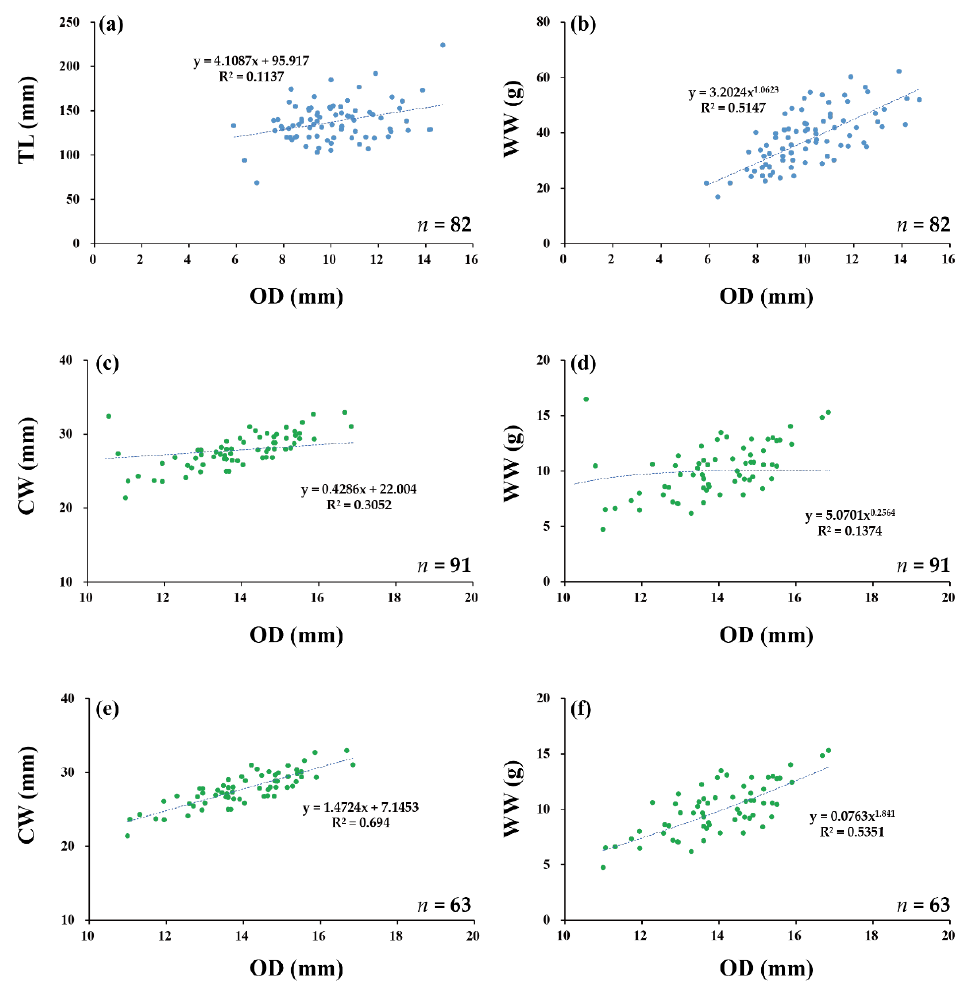
Figure 4. The relationship between ( a ) OD and TL for U. unicinctus , ( b ) OD and WW for U. unicinctus , ( c ) OD and CW for U. major , ( d ) OD and WW for U. major , ( e ) OD and CW for U. major without abnormal openings, and ( f ) OD and WW for U. major without abnormal openings.